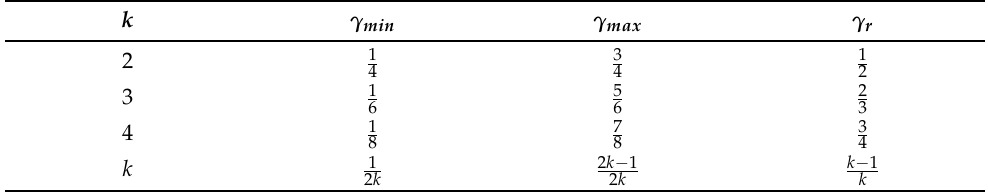
Table 3. The dimming range of the block coding scheme under different k .